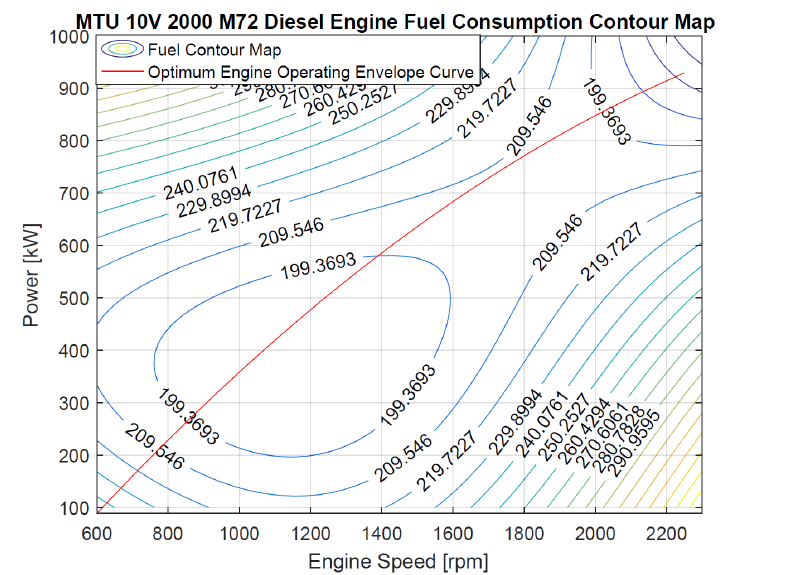
Figure 8. Fuel contour map